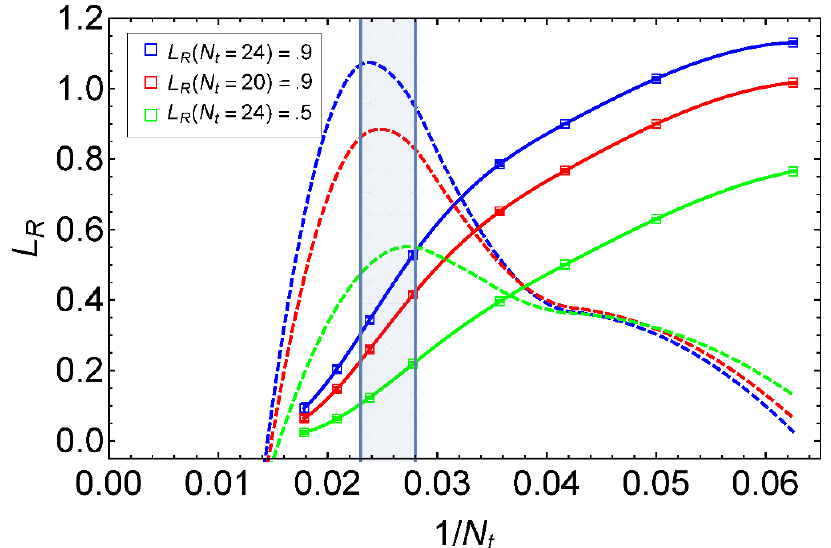
Figure 6 . Renormalized Polyakov loop and their susceptibility. The renormalized Polyakov loops L R denoted by empty squares are obtained from the ensembles of N t (cid:2) 16 2 (cid:2) 24 with N t ranged over [16 ; 56]. The solid curves are the interpolation of L R connected by cubic splines, while the dashed curves are the corresponding susceptibility (cid:31) ( L R ), the derivatives of L R with N (cid:0) 1 are associated with di(cid:11)erent renormalization conditions, while the blue band denotes the (pseudo- )critical temperature T c with uncertainties as described in the